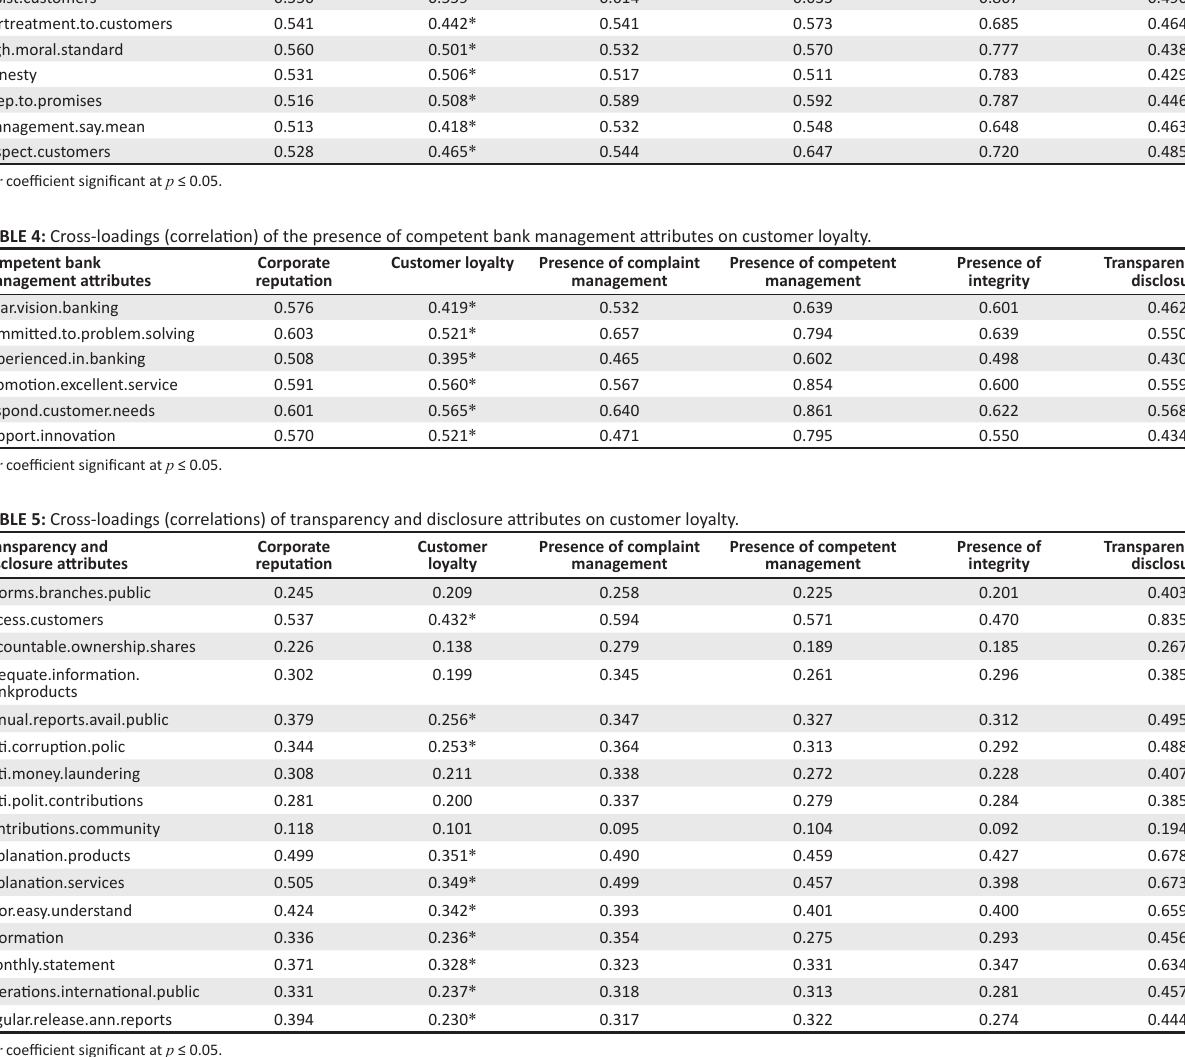
TABLE 3: Cross-loadings (correlations) of the presence of bank management attributes with integrity on customer loyalty. Bank Management with Integrity